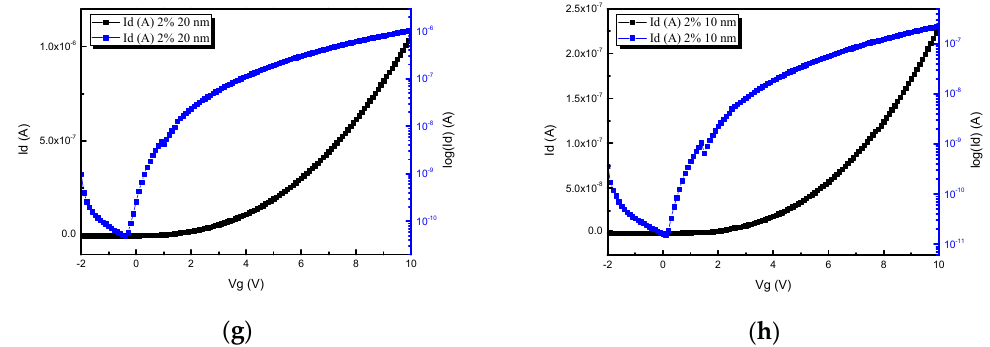
Figure 7. Output characteristics of MIO TFTs with various channel layer thicknesses: ( a ) sample T2, ( b ) sample T4, ( c ) sample T5, ( d ) sample T6. Transfer characteristics of MIO TFTs with channel active layer thicknesses: ( e ) sample T2, ( f ) sample T4, ( g ) sample T5, ( h ) sample T6.